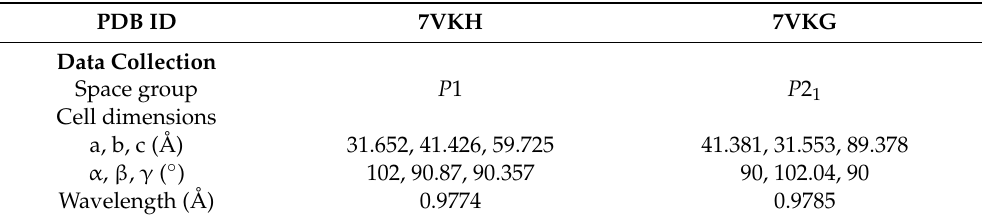
Table 2. X-ray crystallography data collection and refinement statistics for the AF9-inhibitor